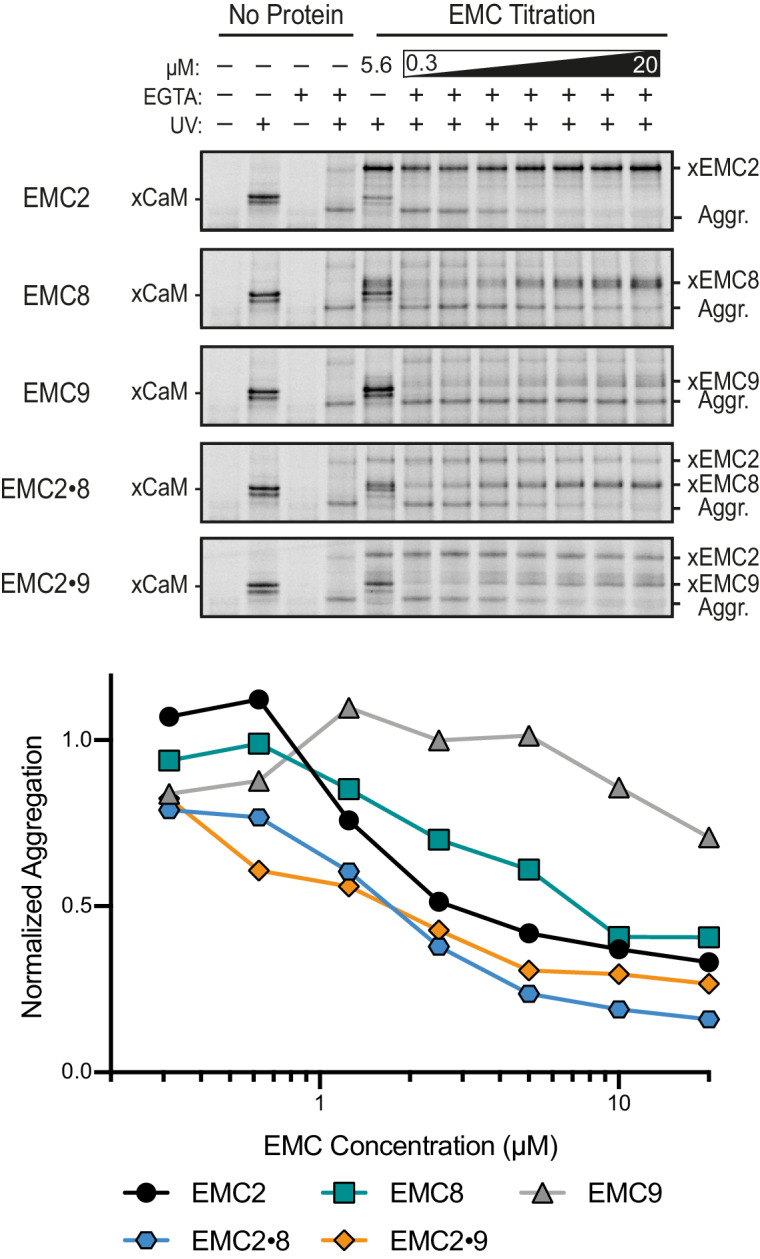
Activity of EMC cytosolic subunits in preventing TMD aggregation.35S-methionine labeled SQS containing the benzoyl-phenylalanine (Bpa) photo-crosslinker within the TMD was prepared in complex with CaM as characterized in Figure 1C. The complex was mixed with various concentrations of different proteins (indicated on the left), treated with EGTA to release the substrate from CaM, and substrate interactions monitored by UV-mediated crosslink formation. Release from CaM in the absence of any additional protein results in UV-dependent self crosslinks indicating of aggregation (Aggr.). This aggregate product is progressively reduced to a comparable extent by the inclusion of EMC2, EMC2•EMC8, or EMC2•EMC9. By contrast, EMC9 alone is not able to reduce aggregation, while EMC8 alone has a partial effect on aggregation. Note that the crosslinking observed to EMC9 when it is added in isolation is probably due to its co-aggregation with substrate and not a protective interaction because the substrate aggregate product is not diminished appreciably. The plot below the gels quantifies the relative intensity of the aggregate band normalized to the sample without added protein.